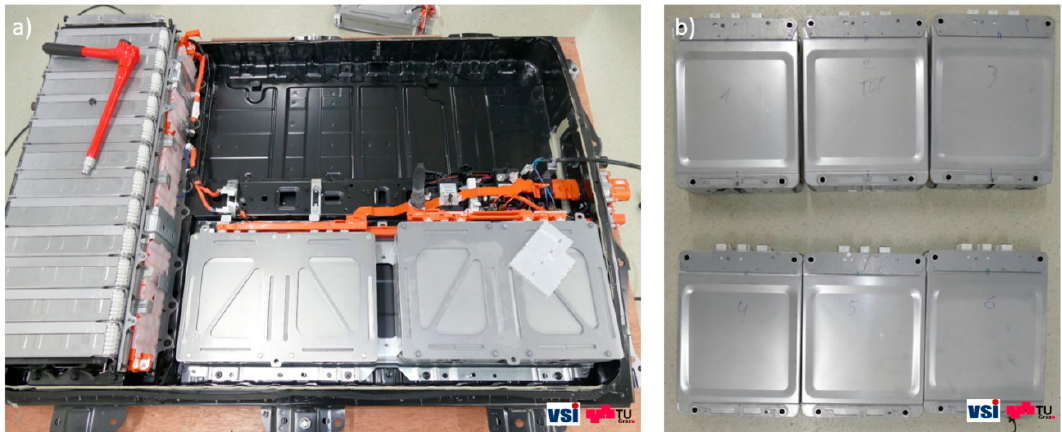
Figure 1. ( a ) Disassembly of the battery pack showing horizontally and vertically oriented modules inside. A total number of 24 modules were extracted, each of which contained eight cells; ( b ) six modules, which were taken out of the battery pack.